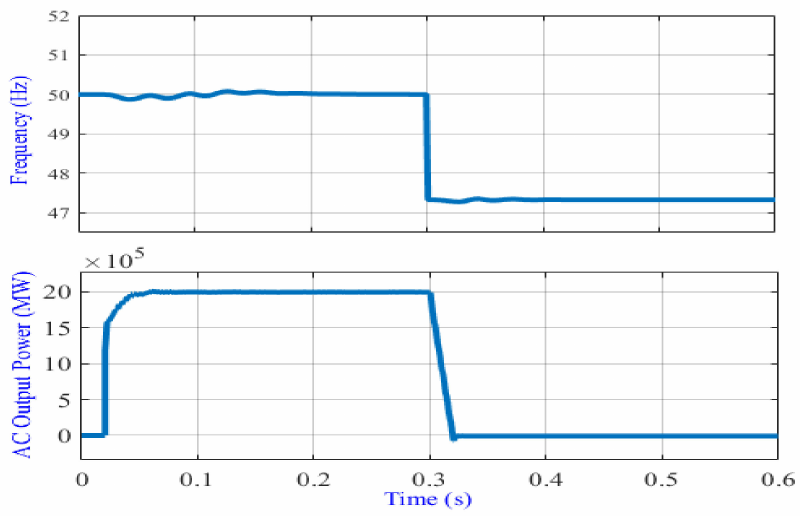
Figure 16. Active power control behavior during normal and less than 47.5 Hz frequency.